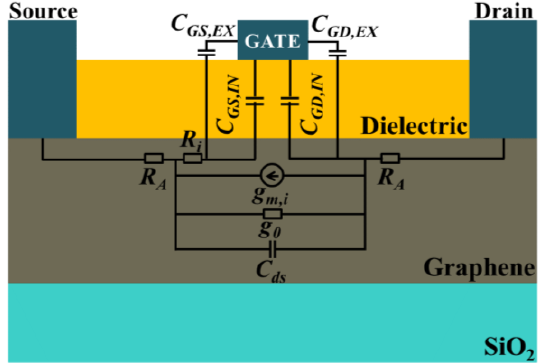
Figure 1. Small signal equivalent circuit overlaid on top of a conventional graphene field-effect transistors (graphene FET).